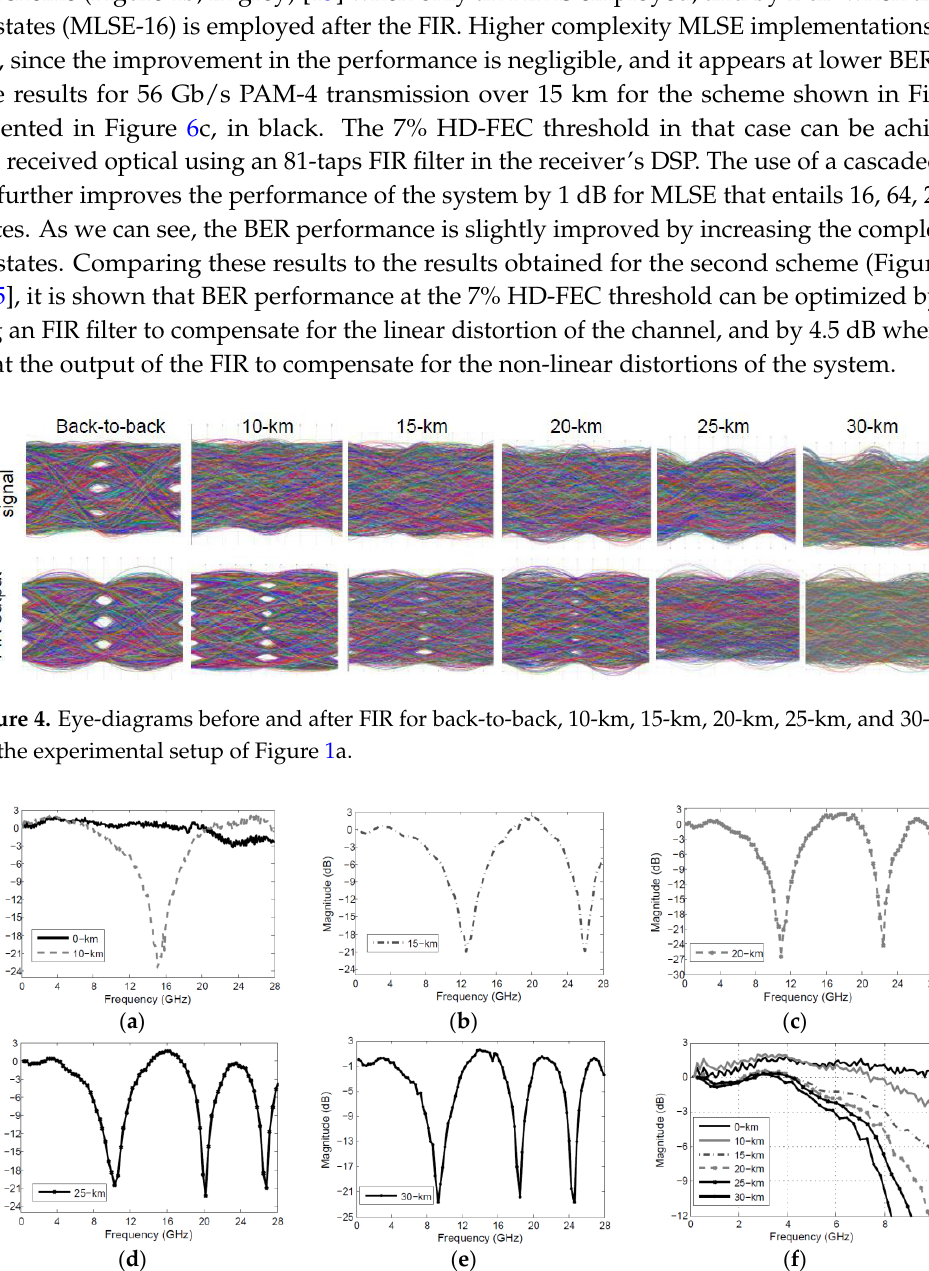
Figure 5. The system’s transfer function measured for ( a ) the back-to-back case, and after transmission over ( a ) 10-km; ( b ) 15-km; ( c ) 20-km; ( d ) 25-km; and ( e ) 30-km; ( f ) 3-dB bandwidth of the transfer functions for all scenarios under investigation.